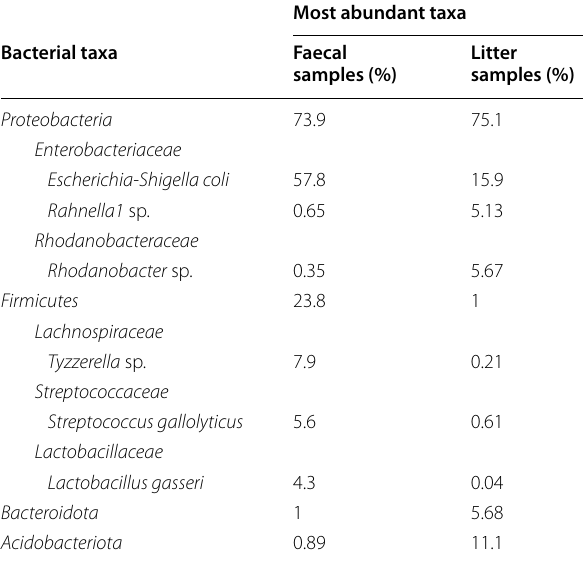
Table 2 Relative abundance of the most abundant bacterial phyla and species across faecal and litter